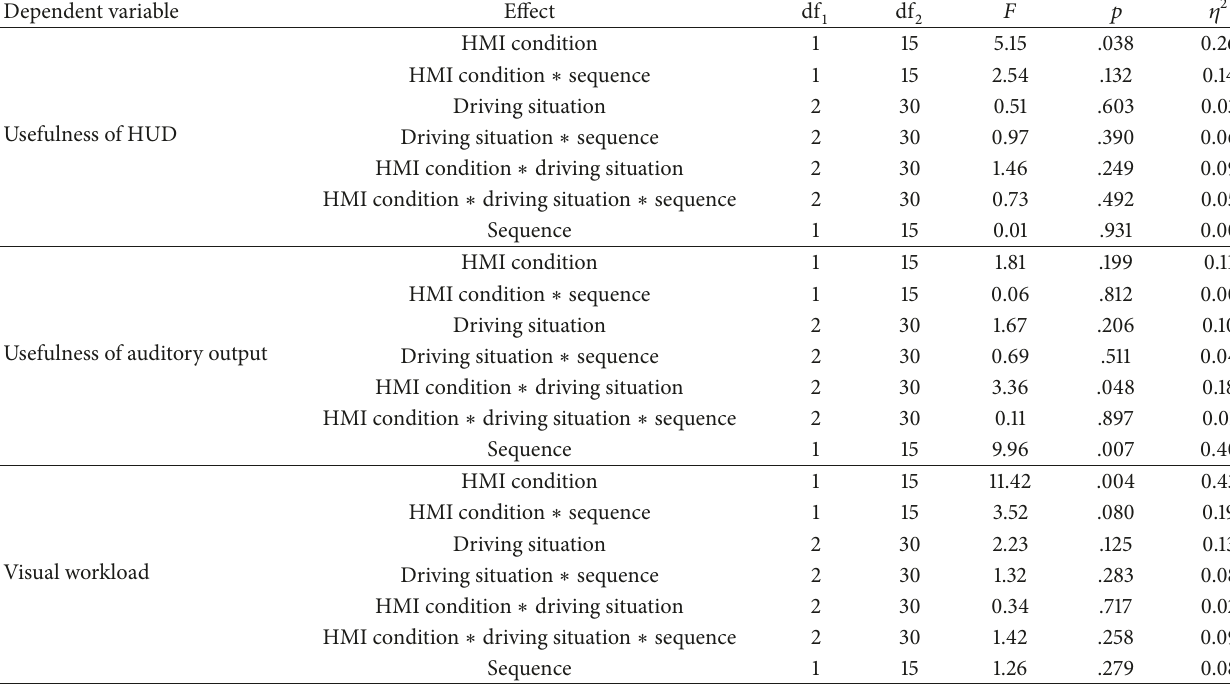
Table 6: ANOVA results: usefulness and visual